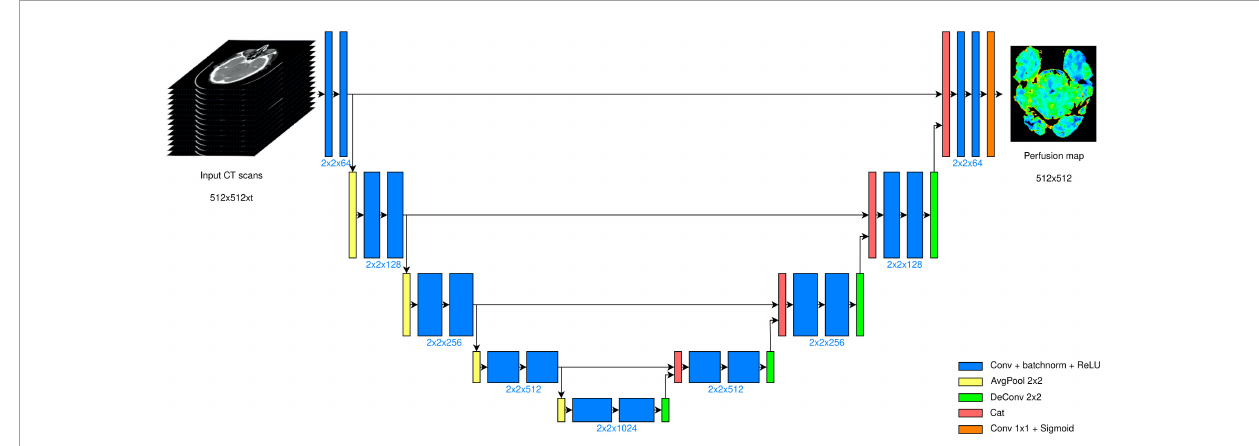
FIGURE1 U-Net architecture deployed. The model takes scans of size 512 × 512, acquired in t different time instants. The bottleneck layer is placed after four encoding stages, and the output is a 512 × 512